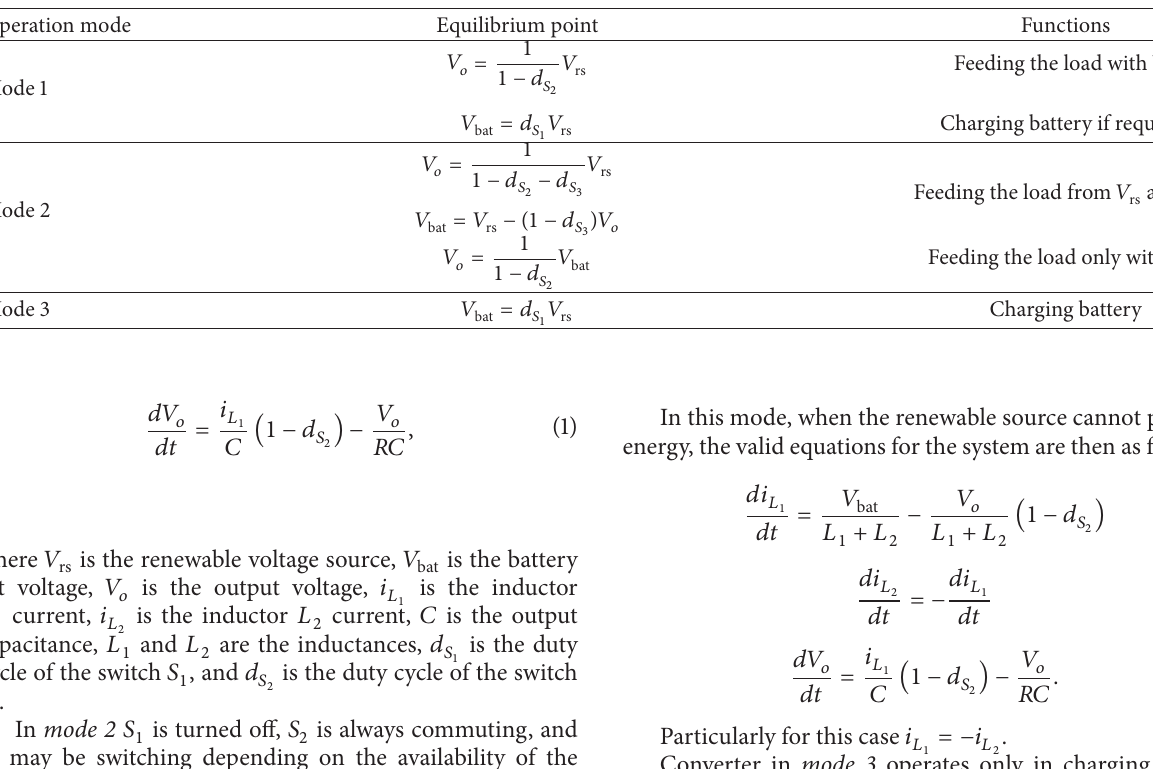
Table 2: Equilibrium point of the operation